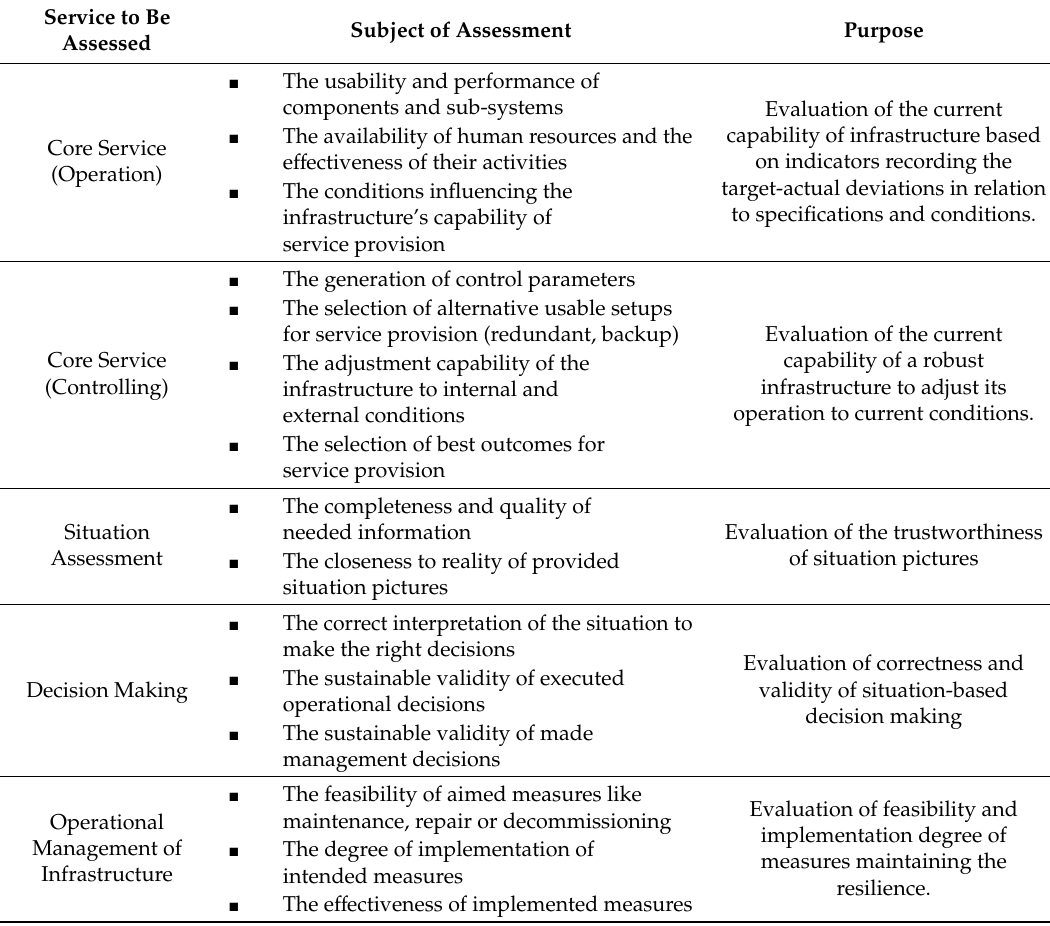
Table 3. Services to be assessed and subject of assessment, if “some things (may) go